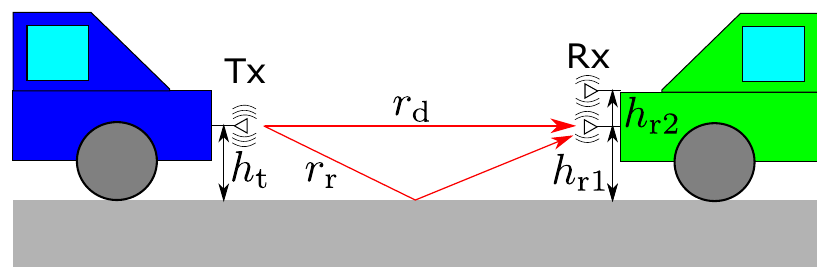
Figure 13. V2V two-ray ground reflection channel